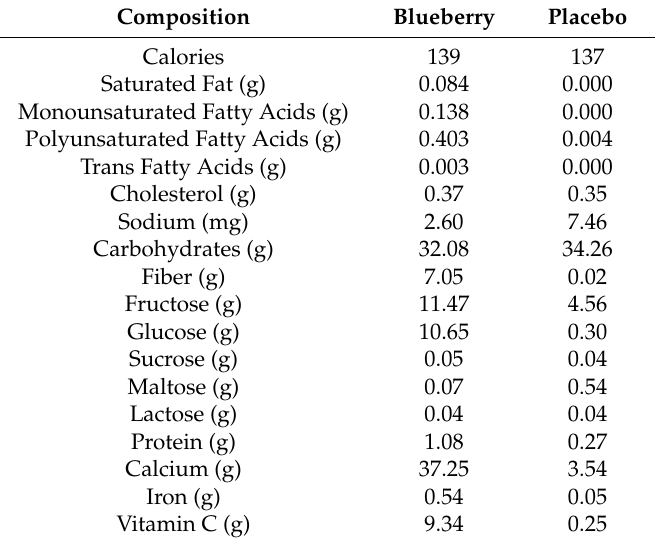
Figure 1. A Consort diagram of the participant flow of the parent clinical trial. Table 1. Average nutrition provided by powders per day if participants were 100% compliant. Composition